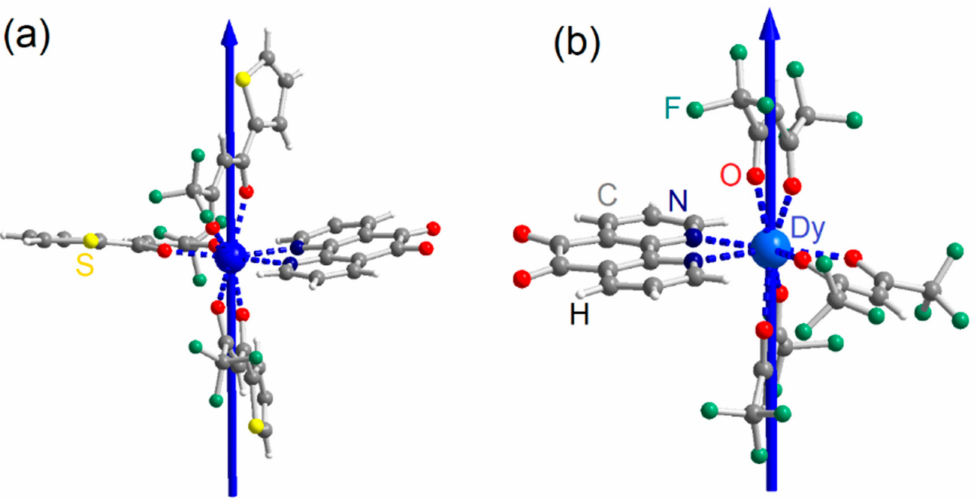
Figure 1. Molecular structures of 1 ( a ) and 2 ( b ) with representation of the main component (g z ) of the computed ground state anisotropy axis. Color code: gray: carbon, dark blue: nitrogen, red: oxygen, green: fluoride, yellow: sulfur, blue: dysprosium, white: